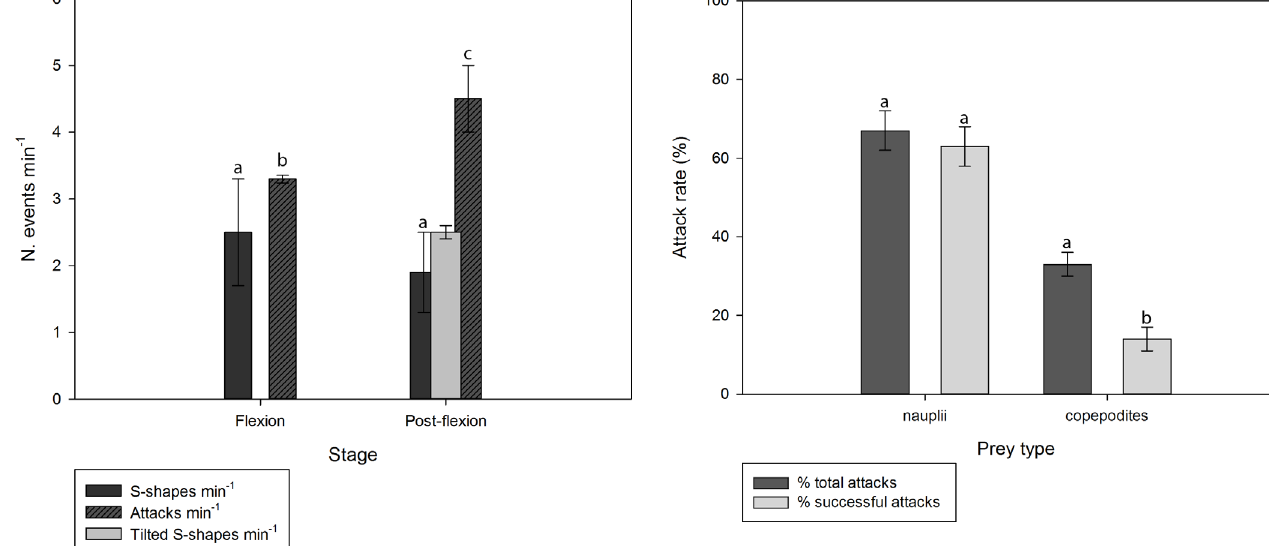
Fig. 5. Post- fl exion attacks in relation to prey type: (a) rate of total attacks and (b) rate of successful attacks on nauplii and copepodites. Bars that share the same letter are not signi fi cantly different ( p < 0.05) within each prey type. Values are given as mean